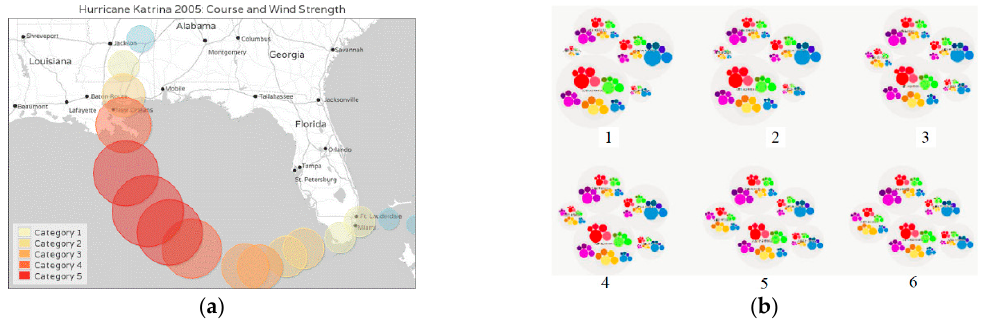
Figure 47. Examples of bubble charts: ( a ) a trajectory-event visualization; and ( b ) temporal transformation results.